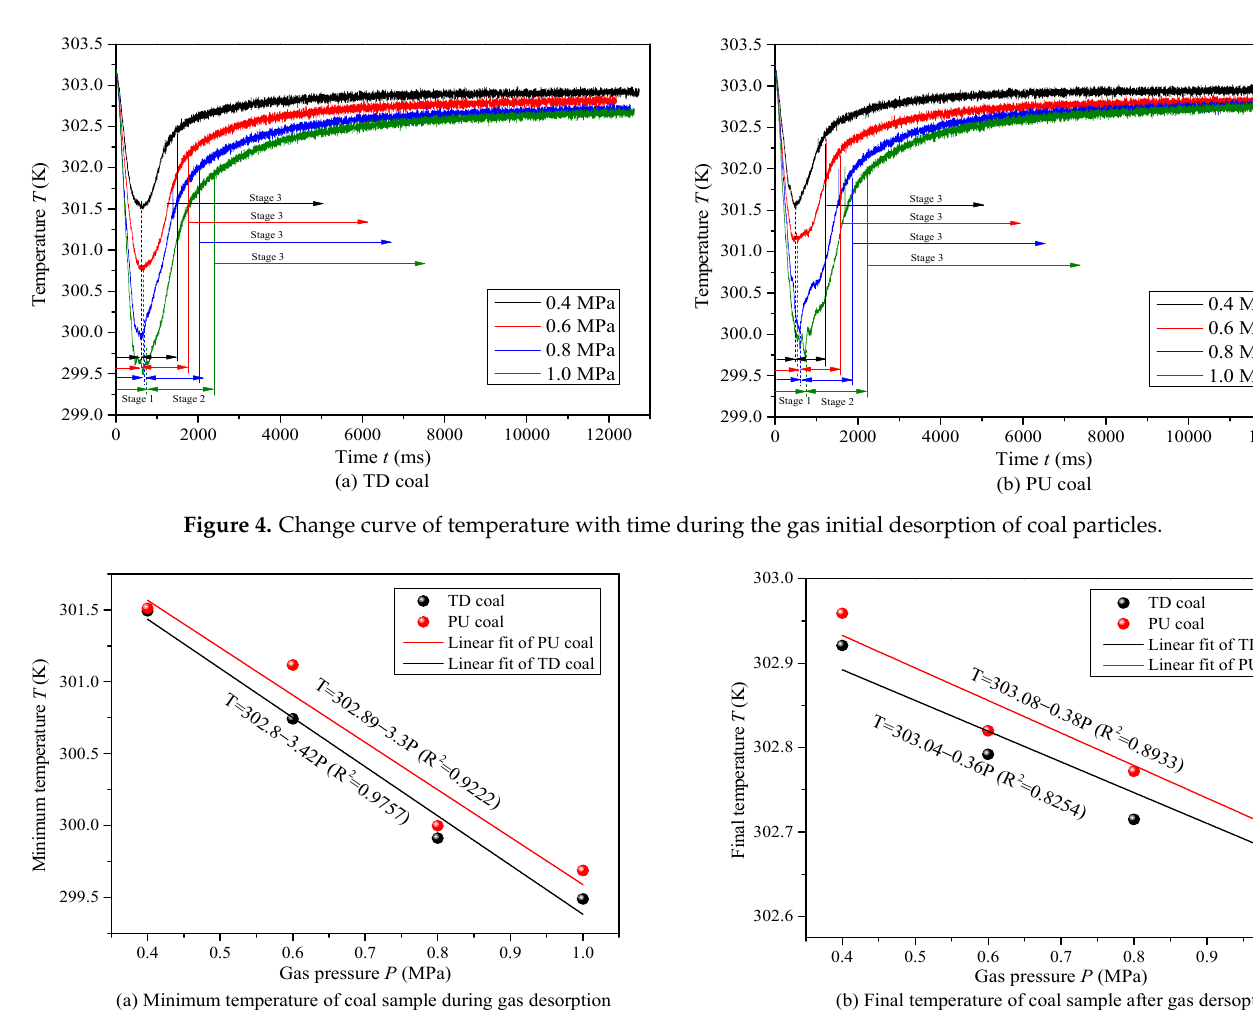
Figure 5. Relationship of the temperature vs. gas pressure.